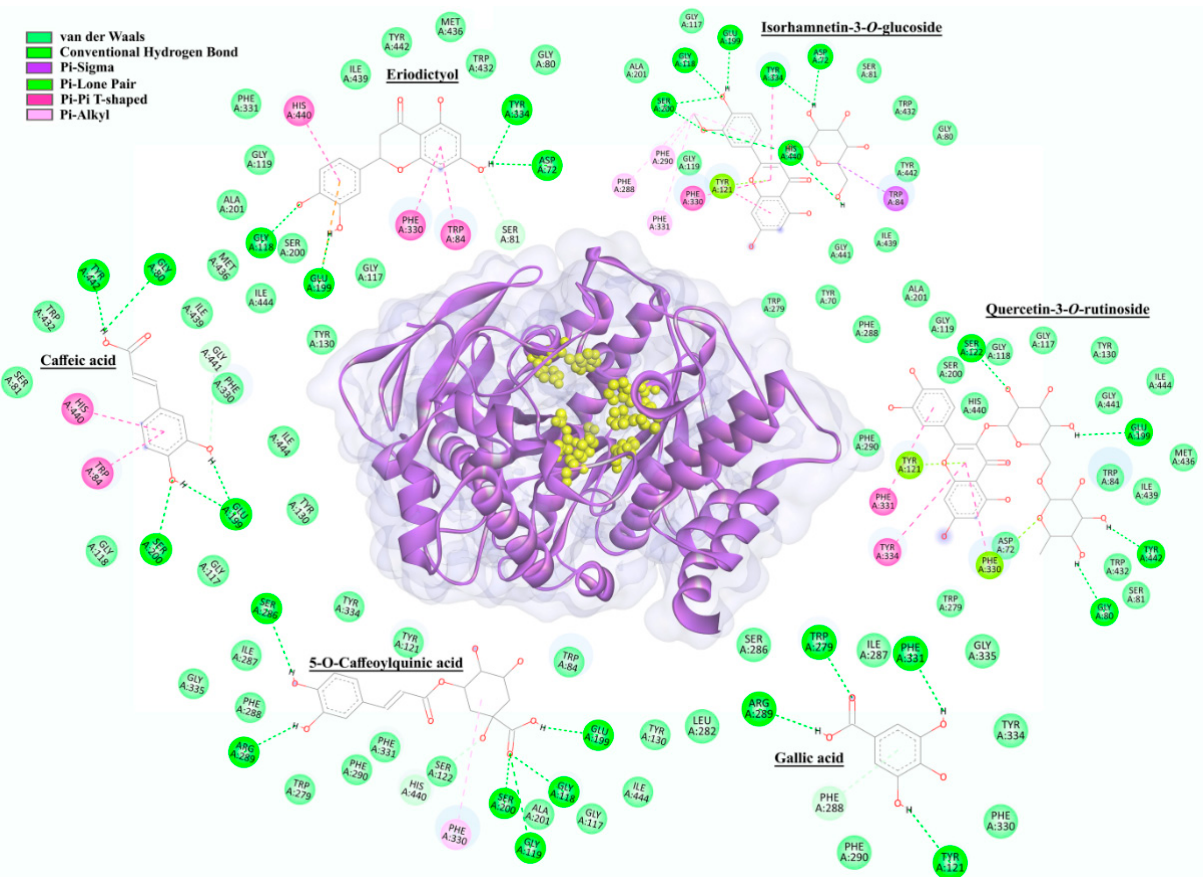
Figure 6. The 2D intermolecular interactions of selected representatives within the active site (marked with yellow) of AChE (2CKM).